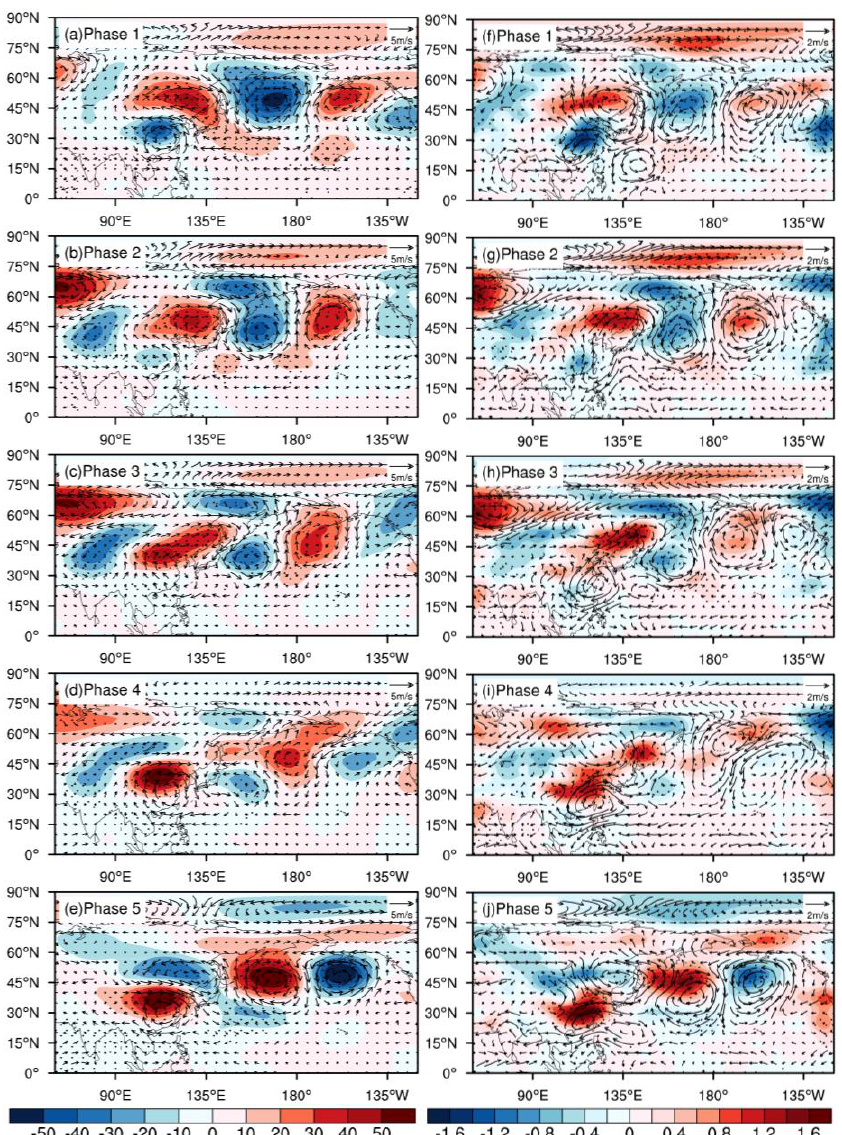
Figure 5. Temporal evolution of 10 – 30 d filtered ( a – e ) 200 hPa geopotential height (shading; units: gpm) and 500 hPa winds (vector; units: m/s), ( f – j ) 850 hPa temperature (shading; units: °C) and winds (vector; units: m/s) for the first type of PHTEs. Black dots represent geopotential height anomalies and temperature anomalies exceeding the 90% confidence level, respectively.